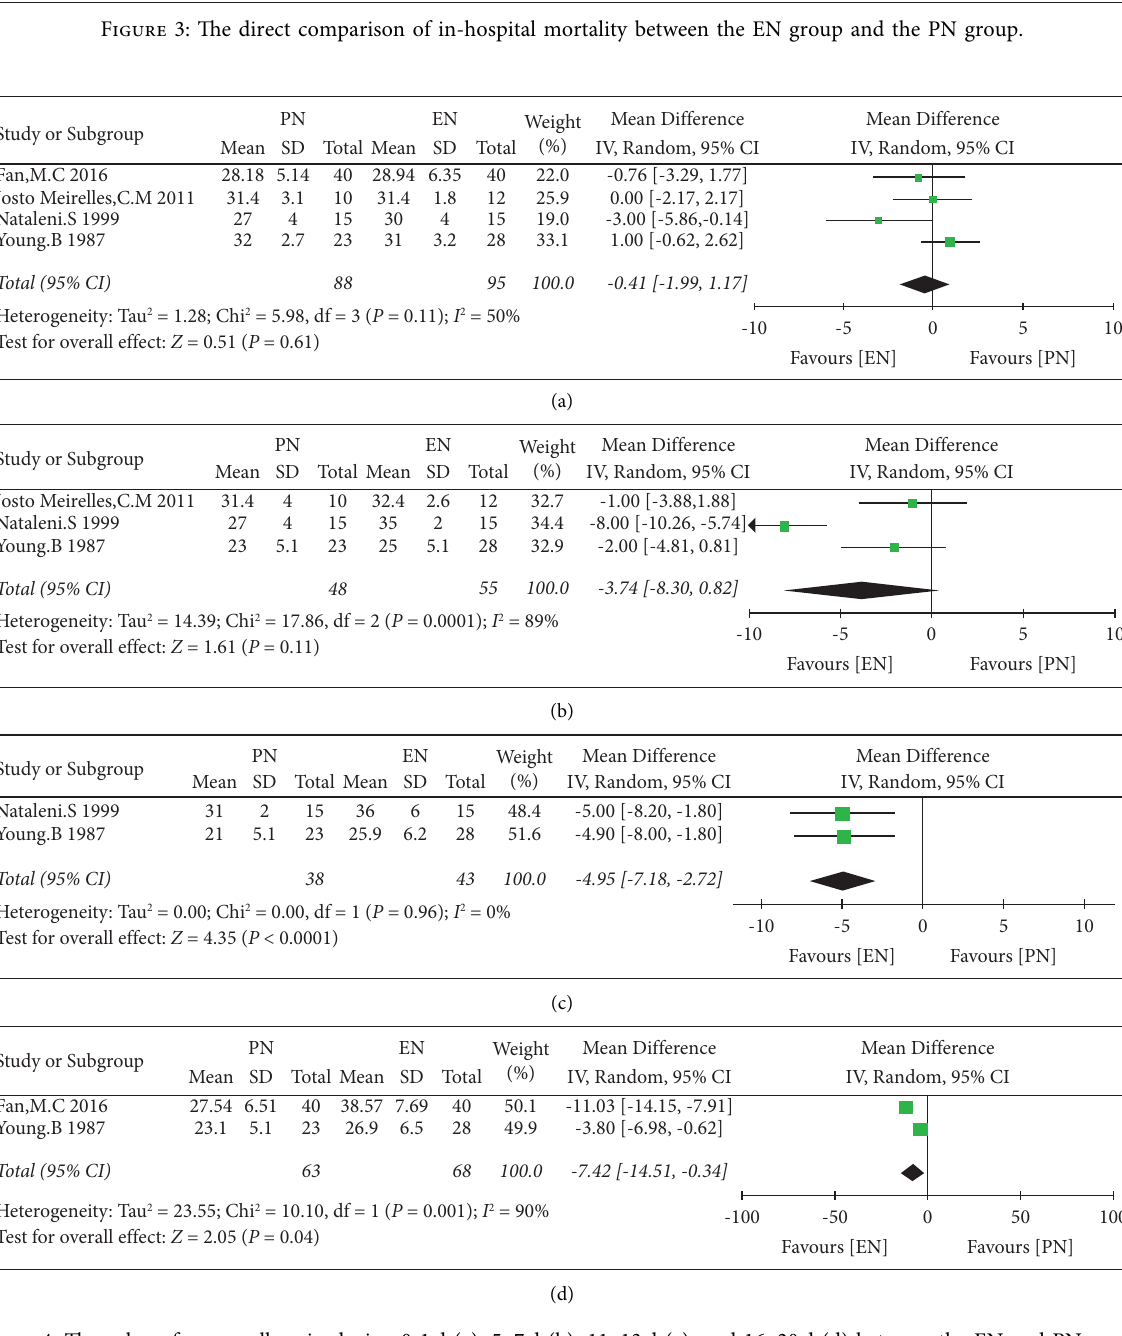
Figure 4: Te value of serum albumin during 0-1 d (a), 5–7 d (b), 11–13d (c), and 16–20 d (d) between the EN and PN